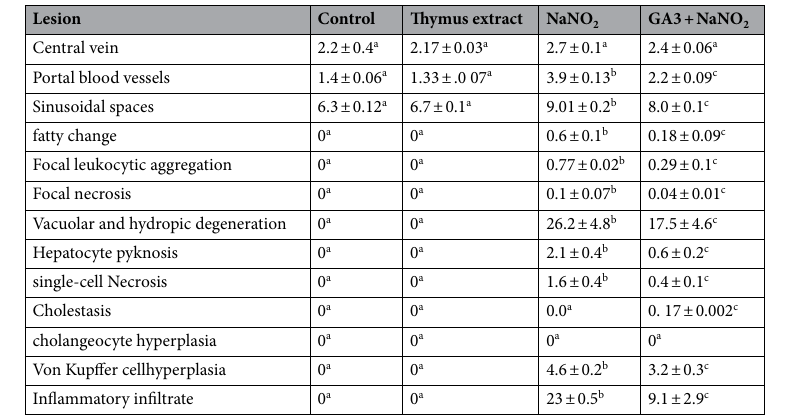
Table 7. Analysis and lesion scoring in the hepatic tissues of mice in response to NaNO 2 and thymus vulgaris treatment. Values are expressed as means ± SEM for 7 different mice per each treatment. Values with different letters means signficant at p < 0.05